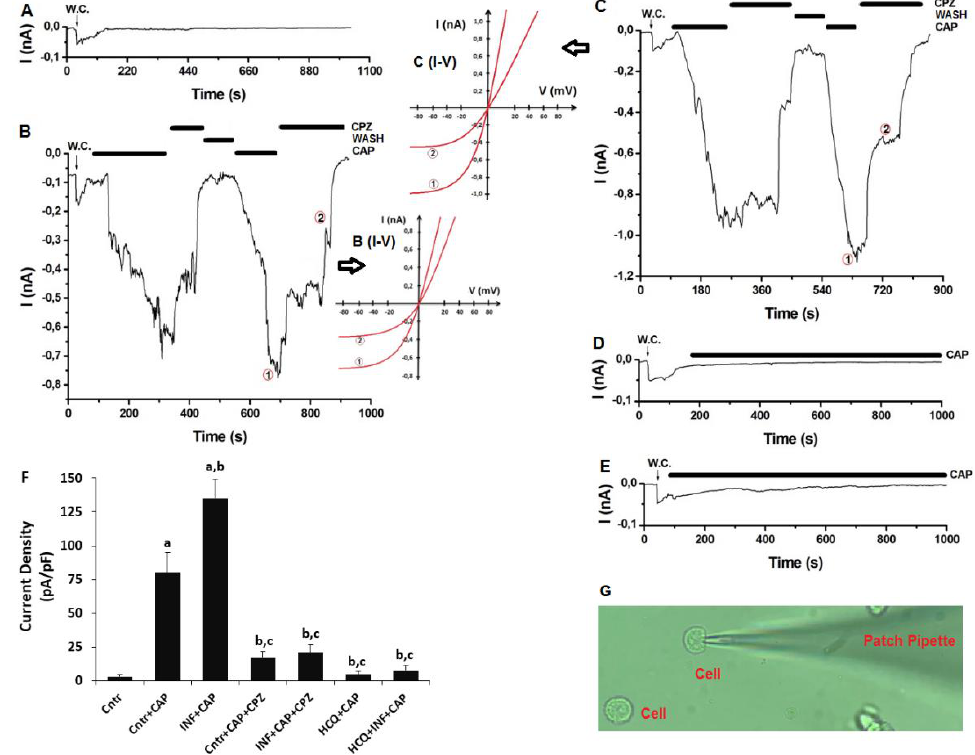
Figure 6. HCQ (60 µ M for 48h) treatment modulated to the acute INF (LPS and 1 µ g/mL for 16h)-caused upregulation of TRPV1 current densities in the U937 monocytes. ( n = 3–6 and mean ± SD). The TRPV1 was activated by CAP (10 µ M), although it was blocked by CPZ (100 µ M). W.C.: whole cell. ( A ) Control (Cntr) (without CAP treatment). ( B ) Cntr + CAP group with the treatments of CAP and CPZ. ( C ) Acute INF + CAP group with the treatment of CAP and CPZ after the LPS treatment. ( D ). HCQ + CAP with CAP treatment after the HCQ incubation. ( E ) HCQ + acute INF + CAP group with the treatment of CAP and LPS after the HCQ treatment. ( F ) The mean densities of TRPV1 current. ( G ). Image of whole cell configuration. ( a p ≤ 0.05 vs. Cntr. b p ≤ 0.05 vs. the group of Cntr + CAP. c p ≤ 0.05 vs. INF+CAP).